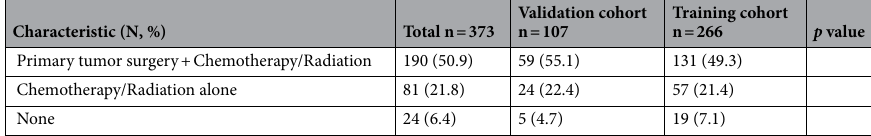
Table 1. Patient characteristics in the study. *Others: bone, brain, distant lymph node, and other